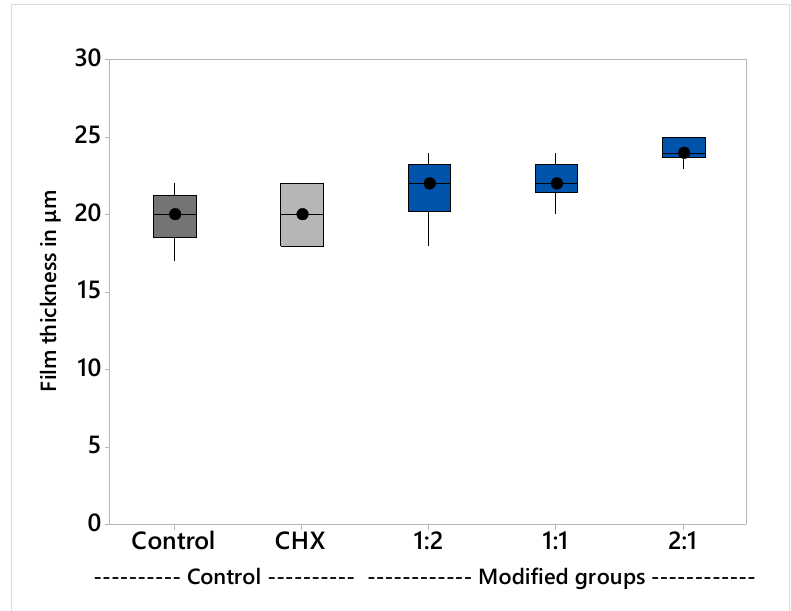
Figure 3. Median film thickness and interquartile range.